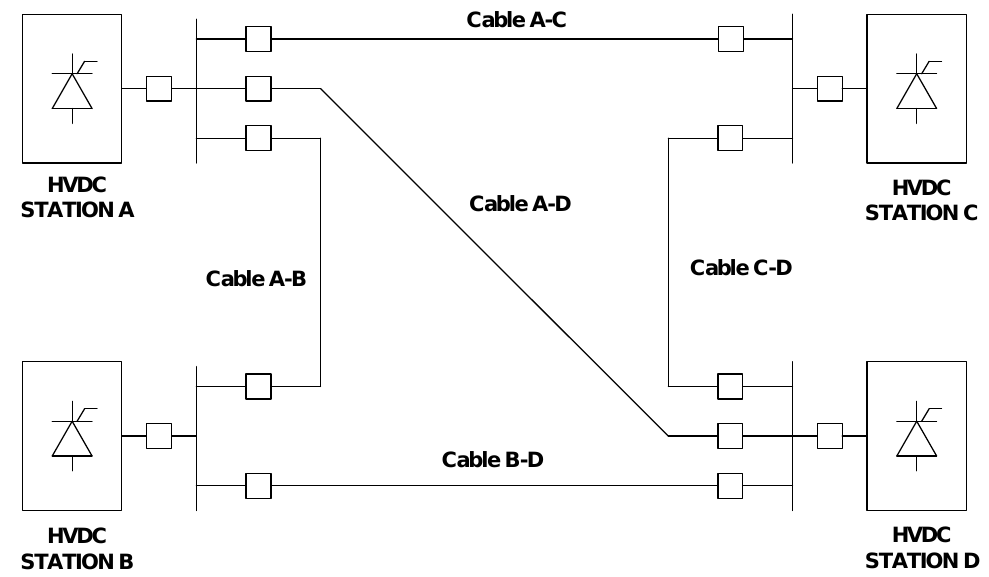
Figure 3. Multiterminal HVDC system configuration with four stations and five cable lines.